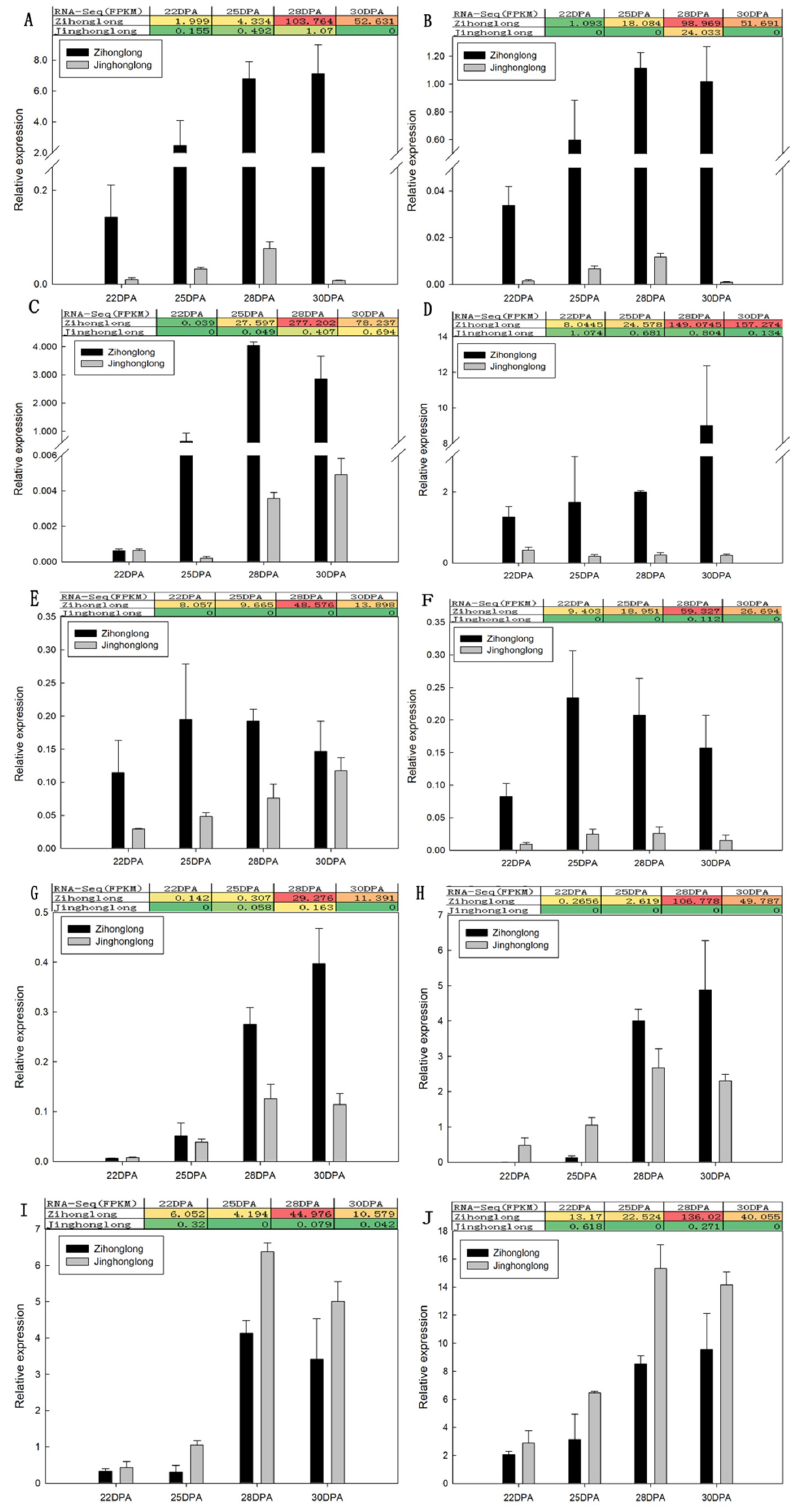
Figure 5. qRT-PCR of candidate gene involved in betalain biosynthesis. ( A ), HpDOD1 ; ( B ), HpDODA2 ; ( C ), HpCYP76AD4 ; ( D ), HpGSTs ; ( E ), HpBPE ; ( F ), HpNAC ; ( G ), HpCYP704C1 ; ( H ), HpFAR ; ( I ), HpSTK ; ( J ), HpVPP1 . Note, the colors in the graph indicate the magnitude of gene expression in the sample. Red indicates that the gene is highly expressed in the sample, yellow indicates that the gene expression is middle, and the blue indicates that the gene expression is